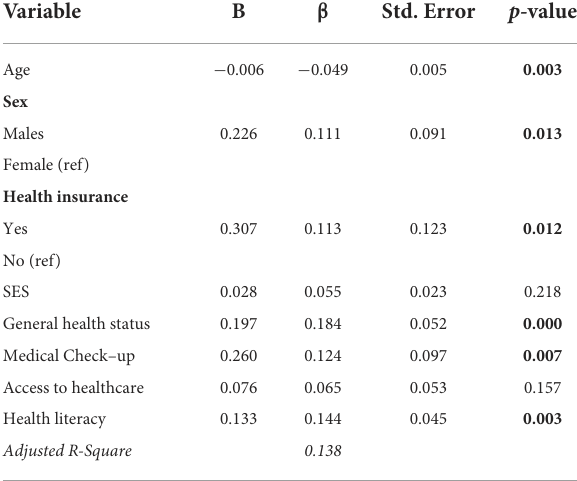
TABLE 3 Association of health literacy, medical check-up, general health status, and access to healthcare with oral health status (derived from the